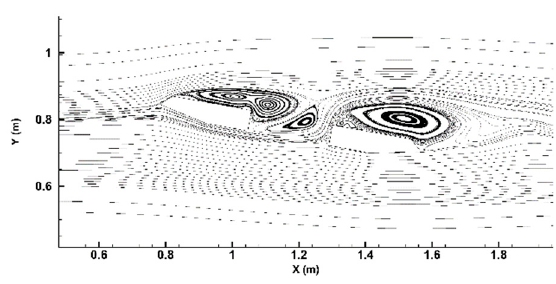
Figure 11. Instantaneous streamlines of AoA = +6.3° at ( a ) 𝑡𝑈 (cid:2998) 𝐷⁄ = 304 and 2𝑡𝑈 (cid:2998) 𝑏⁄ = 69, and ( b )